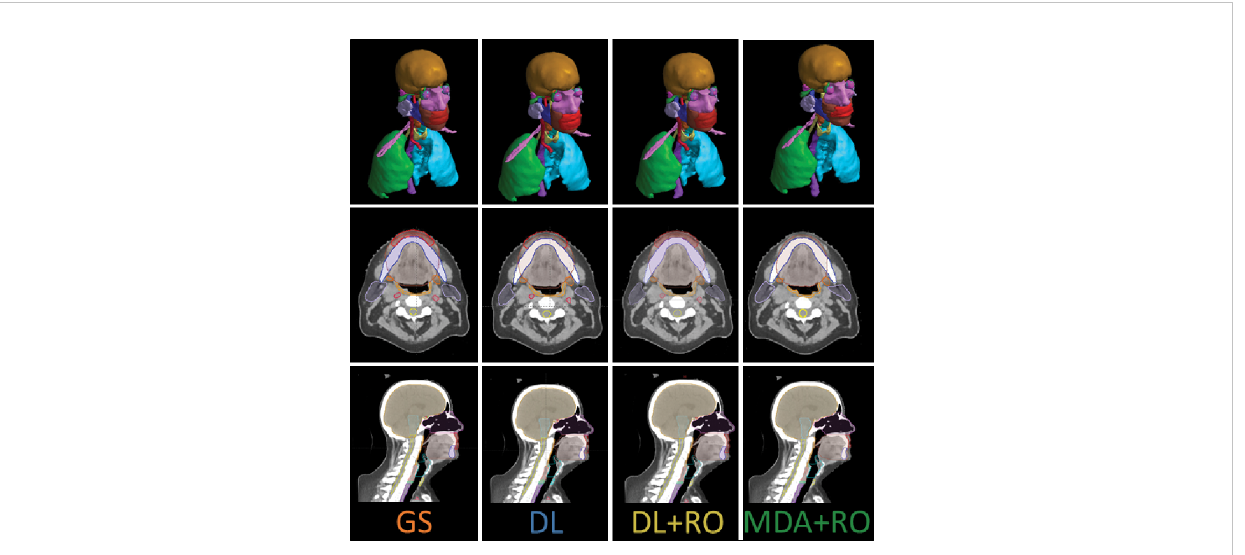
FIGURE 1 3D visualization, and an axial and sagittal slice of the CT with the contours from the gold standard (GS) dataset, as well as the DL, DL+RO, and MDA +RO contours for a representative